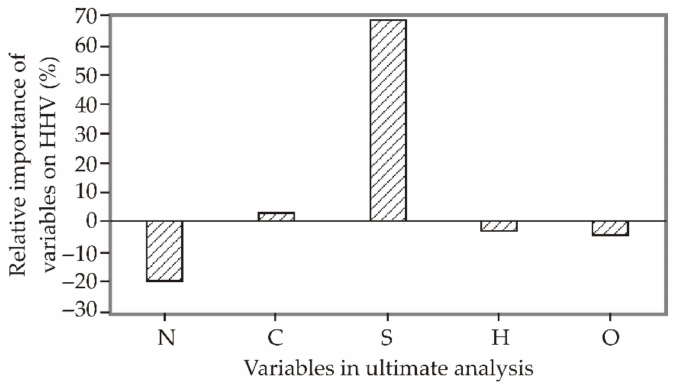
Figure 5. Relative importance of variables on